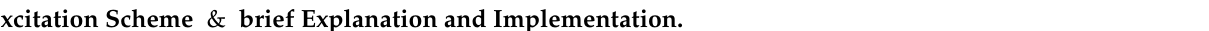
Table 1. Useful excitation schemes for the construction of approximate Green functions